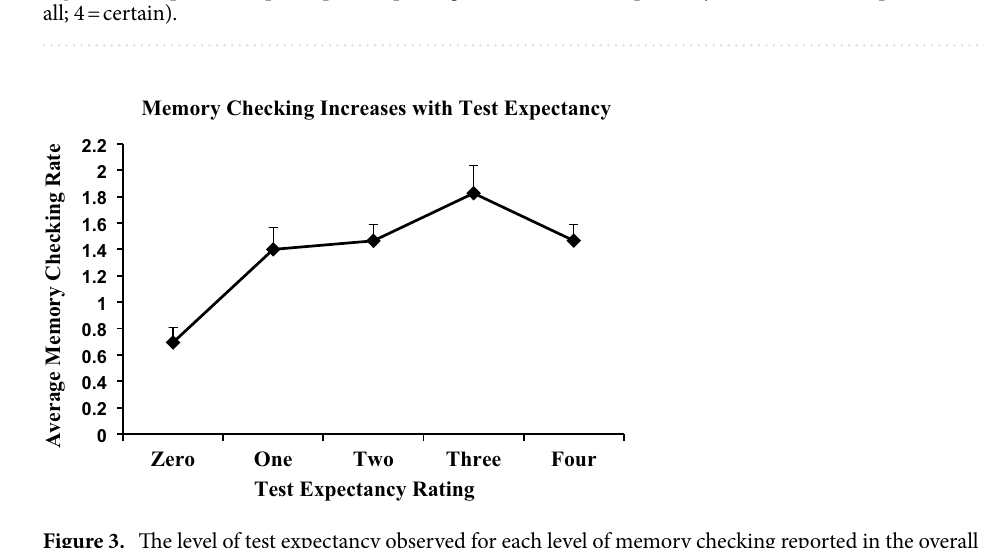
Figure 3. The level of test expectancy observed for each level of memory checking reported in the overall sample. Bars represent + standard